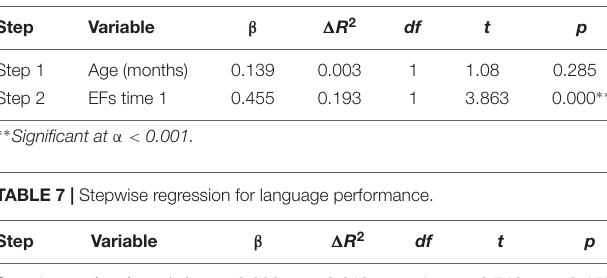
TABLE 6 | Stepwise regression for mathematics performance.